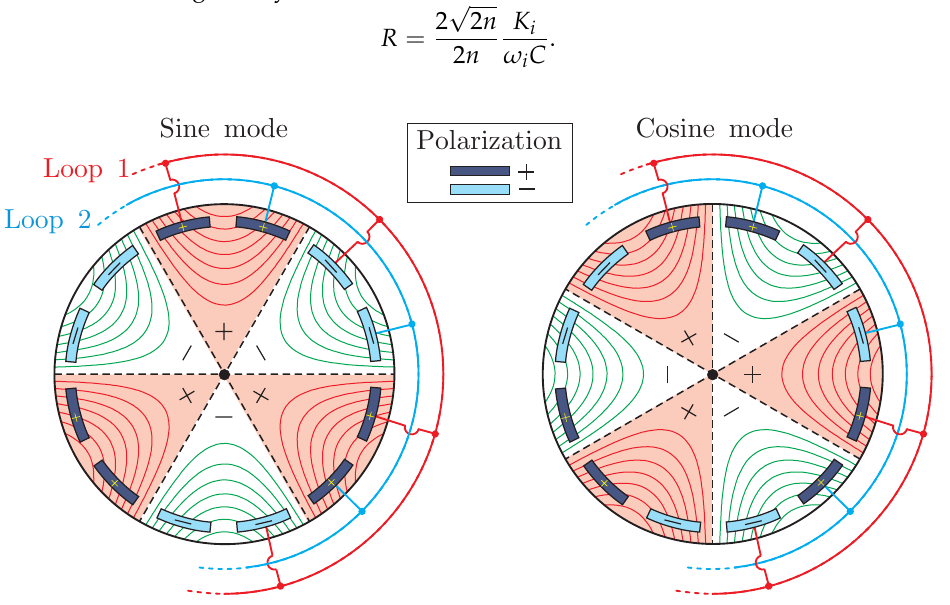
Figure 4. Disk vibrating in the mode n = 3, s = 0, equipped with 4 n patches of PZT regularly spaced on the disk: ( Left ) sine mode ( Right ) cosine mode. The colours of the PZT patches indicate the polarization. The electrical connections between the patches are also